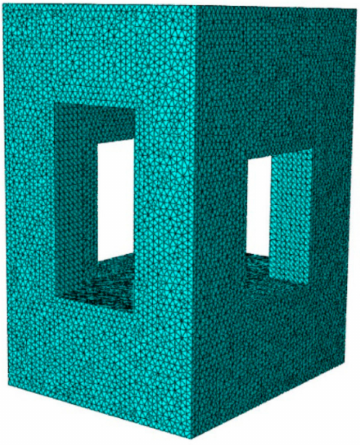
Figure 2. Finite element mesh of the COF machine.